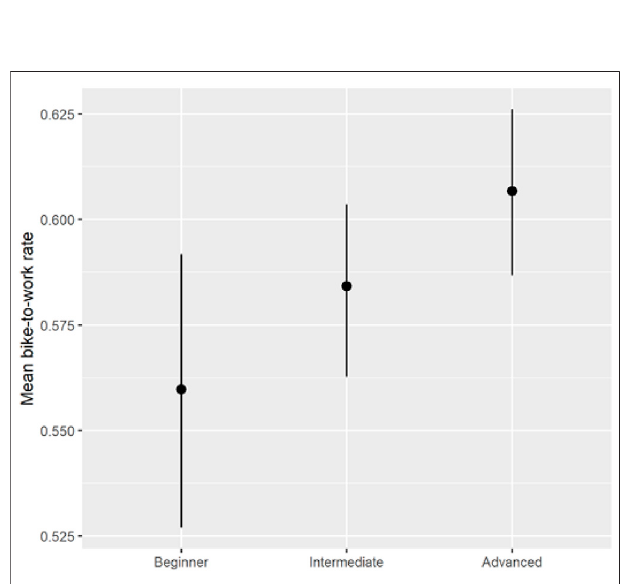
FIGURE 8 | Model predicted mean bike-to-work rate of bike-lending participants by commute type.